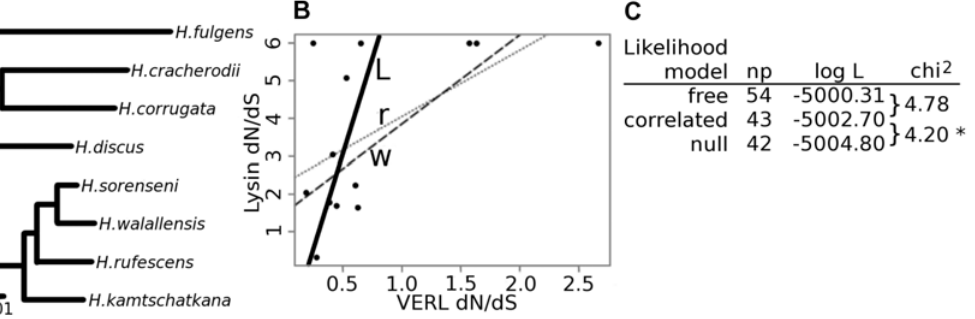
Figure 5. Evolutionary rates at lysin and VERL correlate over an extended timescale. (A) Lysin and VERL d N / d S values were estimated on each branch of an 8 species phylogeny. (B) Lysin d N / d S point estimates are plotted versus VERL for all 13 branches. Note the difference in scale between the axes. Regression lines are plotted for each of 3 methods: a standard linear regression (‘r’, dotted line), a weighted linear regression (‘w’, dashed line), and the line described by our ‘correlated’ likelihood model (‘L’, solid line). (C) Results of our likelihood models. Each model is shown with its number of free parameters (np) and maximum log likelihood (log L). Comparisons between models were made using a likelihood ratio test (LRT). An asterisk (*) indicates a statistically significant difference between models at a